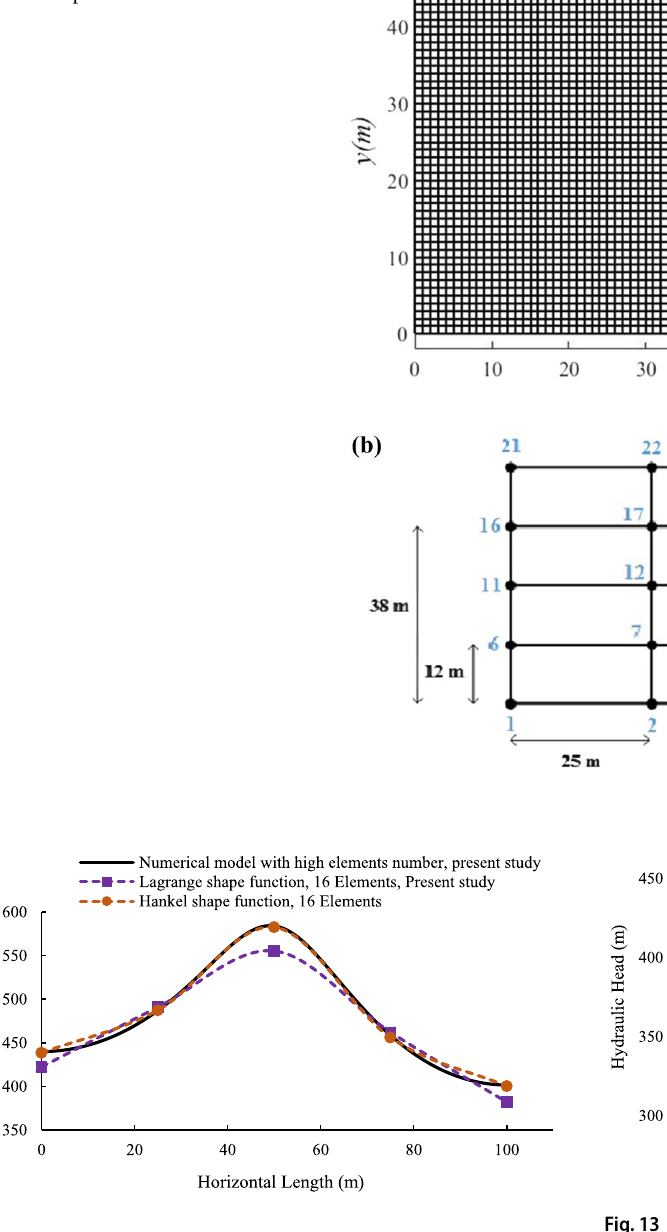
Fig. 11 Meshed domain with a 5000 elements, b 16 elements for the third problem